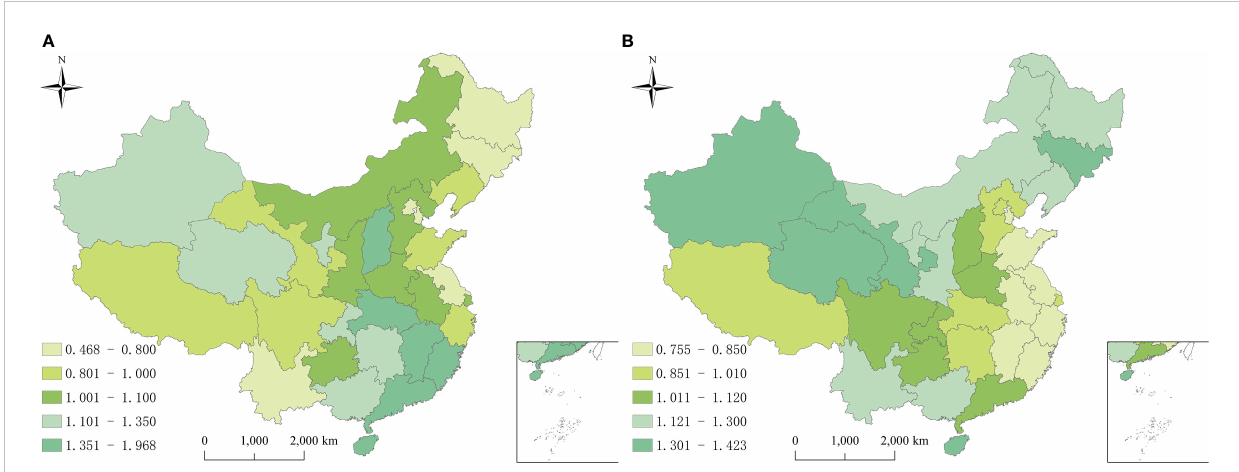
FIGURE 4 Spatial relative risks of hepatitis B and hepatitis C in China from 2010 to 2018. (A) Hepatitis B, high risk areas were mainly distributed in the southeast and northwest regions; (B) Hepatitis B, high risk areas were mainly distributed in the north. The exp ( s i ) is the spatial risk of this disease, which is in fl uenced by some related factors in the study period, such as economic conditions, local prevention and control policies, and medical resources.